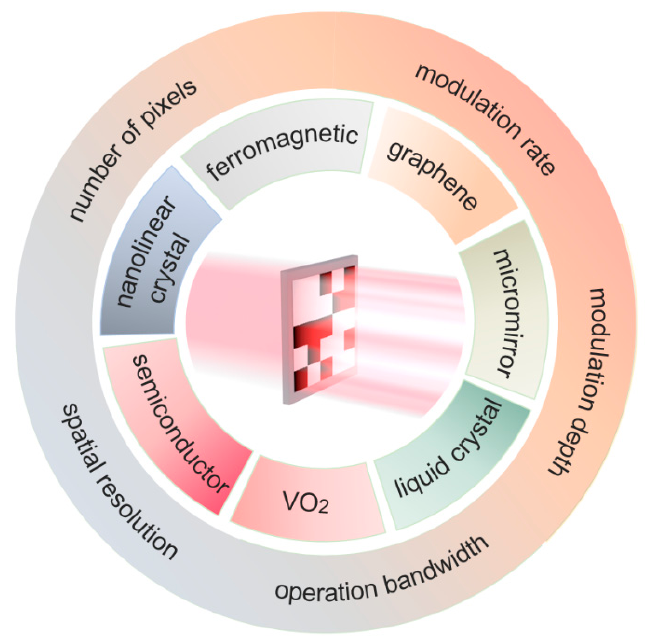
Figure 1. Terahertz spatial light modulators with the functional materials and specifications.